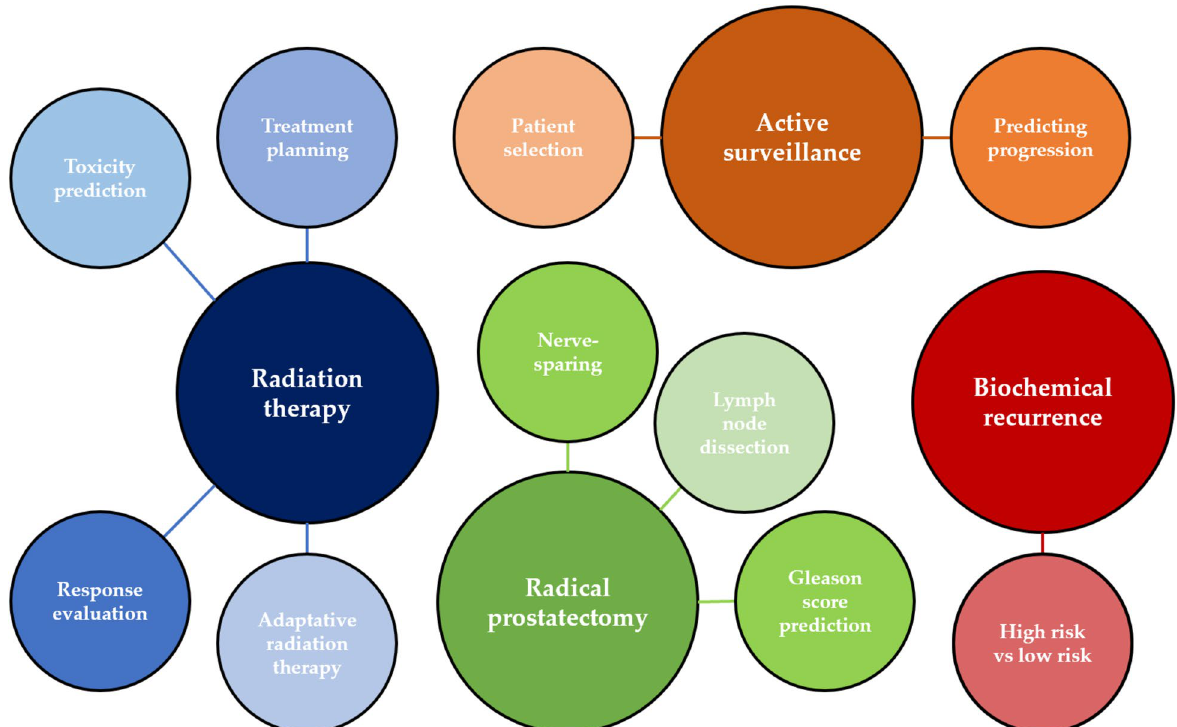
Fig. 1 Graphic representation of radiomics and artificial intelligence main applications in the setting of prostate cancer